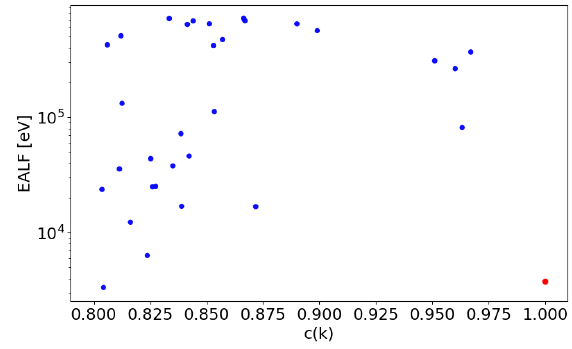
Figure 4d. Updated EALF for the relevant experiments and Case 4.